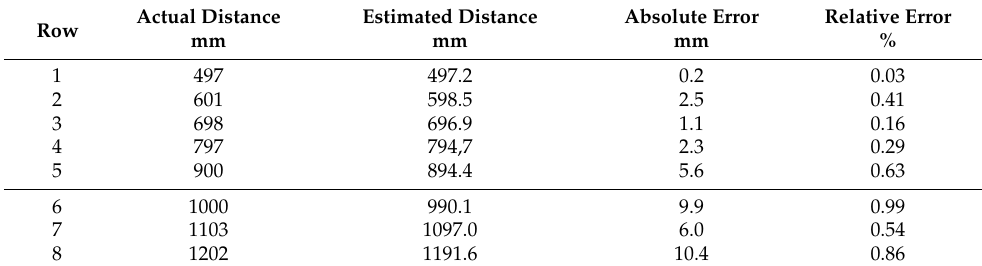
Table 4. The distance between the measurement results.